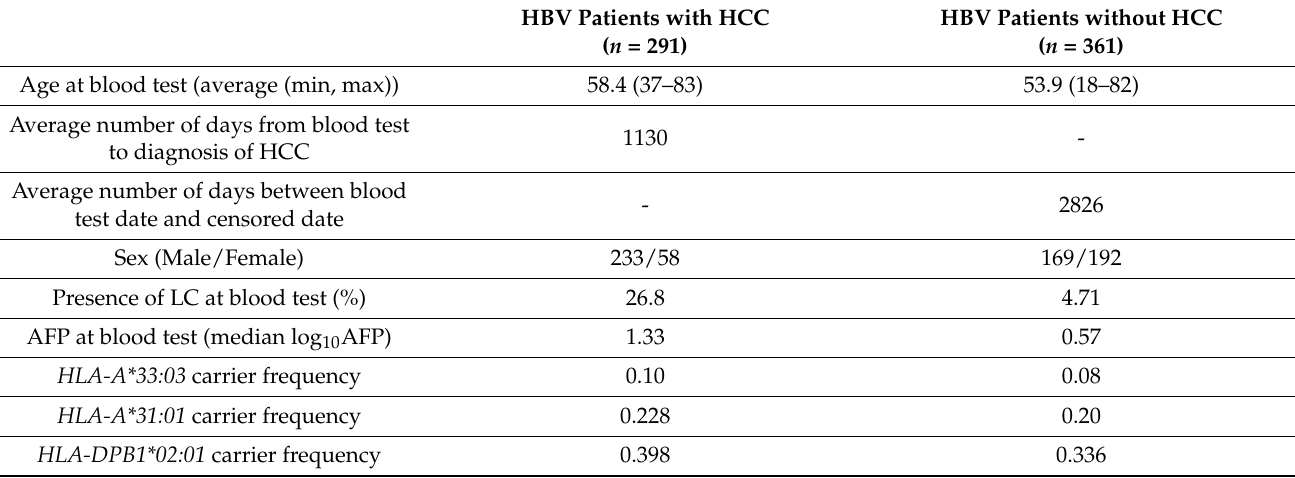
Table 3. Clinical information of all studied